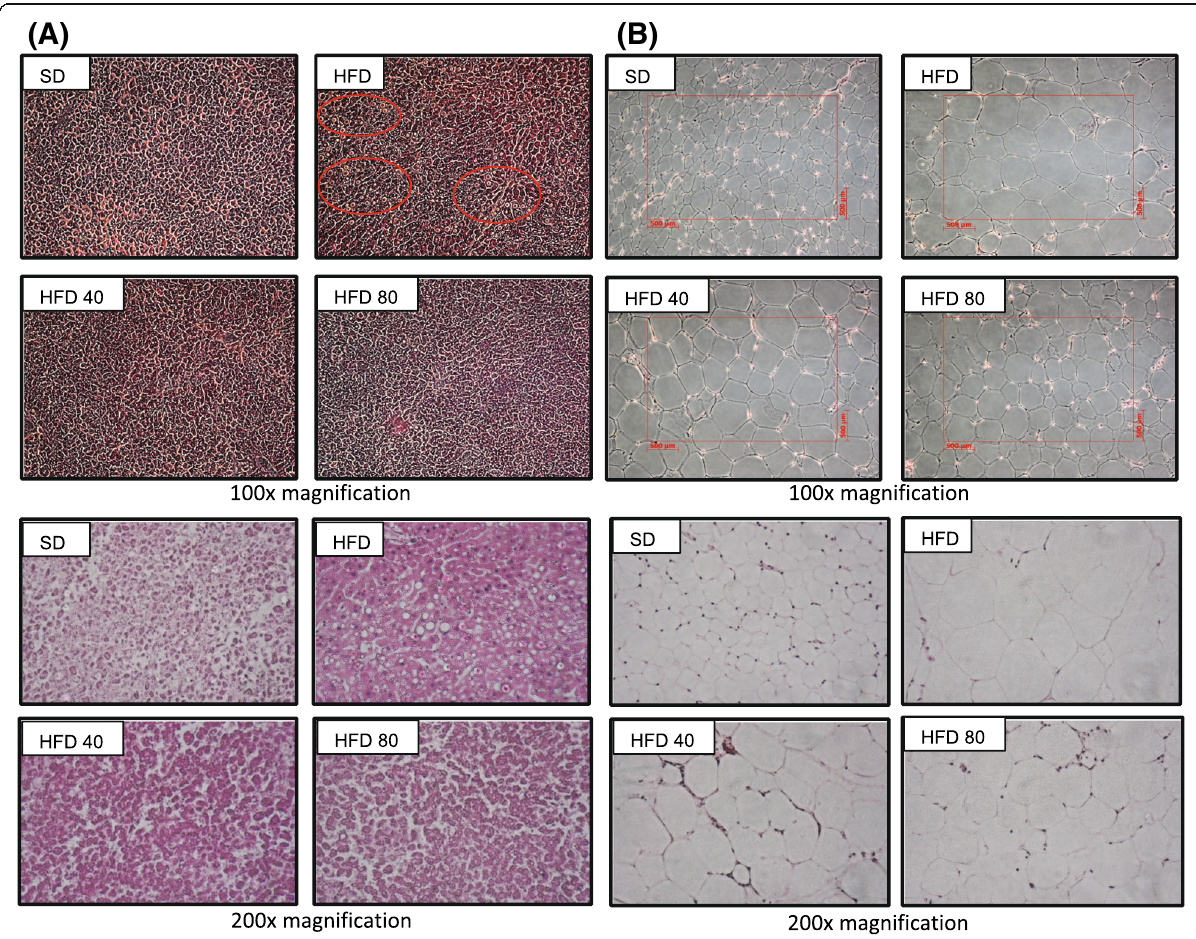
Fig. 10 Histological changes of liver ( a ) and white adipose tissue ( b ) in mice fed a high-fat diet or a purpurin-containing high-fat diet. Each tissue was fixed with 4% paraformaldehyde, and sections were stained with hematoxylin and eosin Y (H&E). Figures represent results from at least three separate